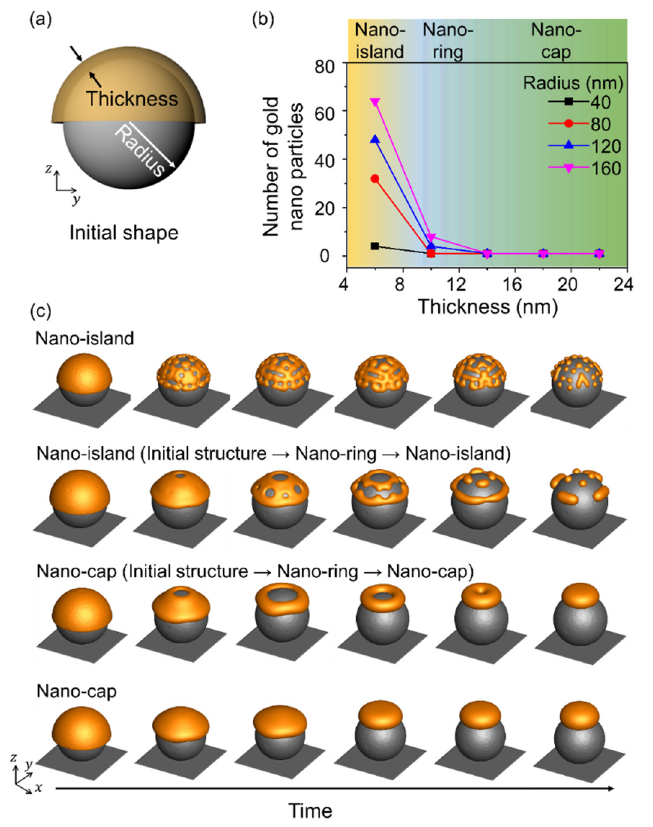
Figure 4. Effects of the radius of the spherical patterns and deposition thickness on the equilibrium morphologies in thermal dewetting. ( a ) Schematic illustration of simulation considering the effects of the radius of the spherical pattern on the substrate and deposition thickness. ( b ) The number of gold nanoparticles formed on the surface of the substrate particle with respect to the deposition thickness and radius. The yellow, blue and green areas correspond to the formation of nano-island, nano-ring, and nano-cap, respectively. ( c ) Time-dependent geometric evolution of the formation of nano-ring, nano-cap, and nano-island.